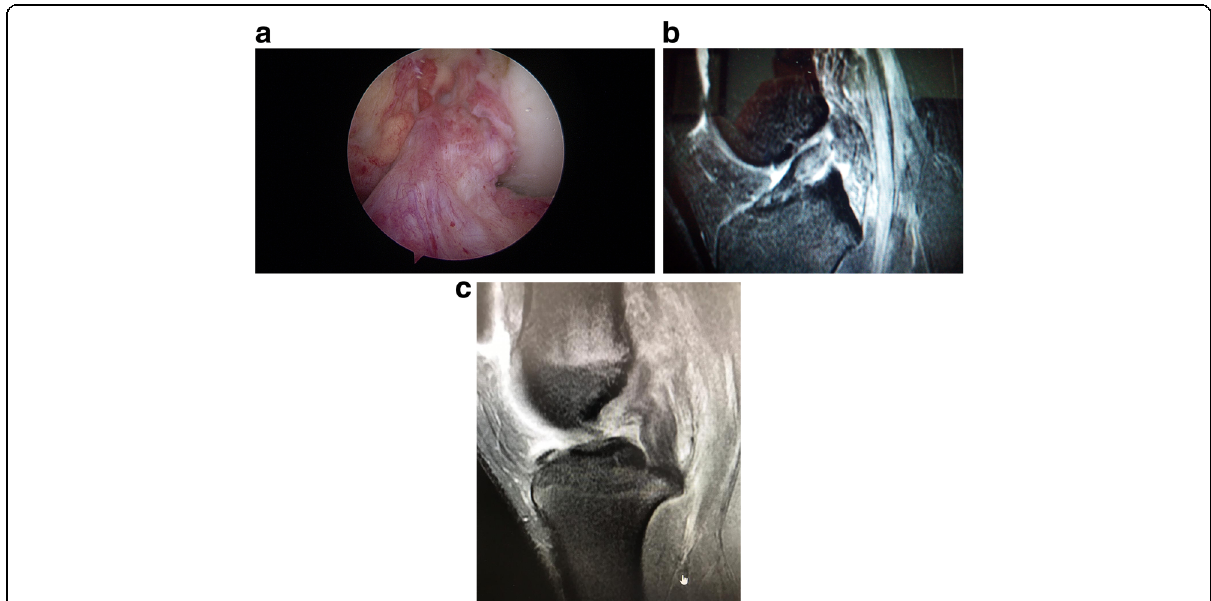
Fig. 12 a ACL proximal rupture. b MRI proximal ACL rupture. c Proximal PCL rupture